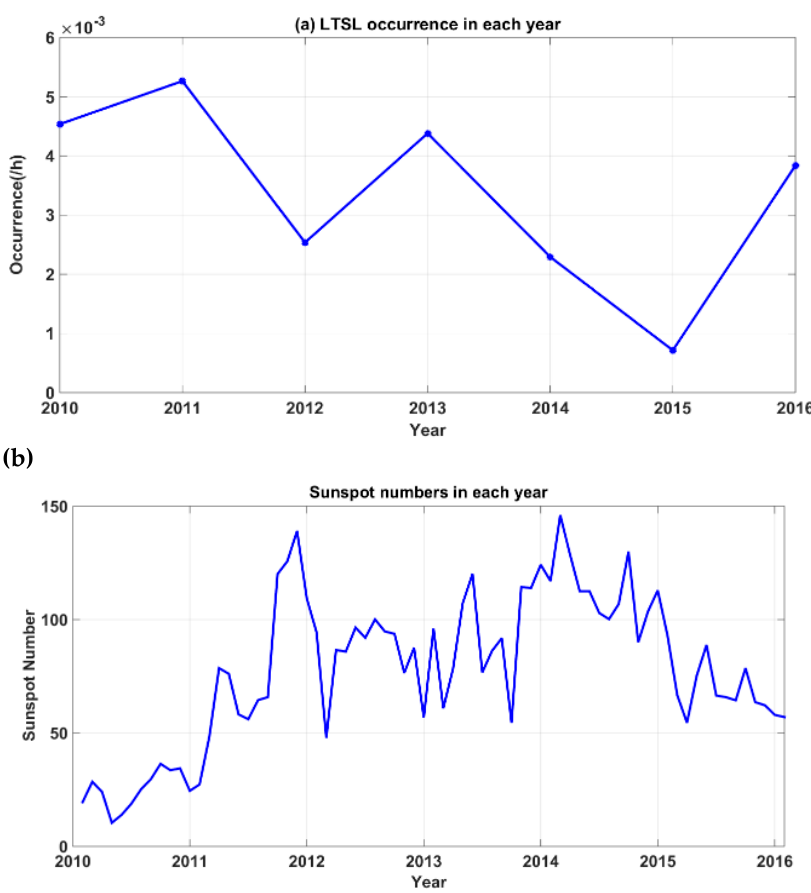
Figure 4. ( a ) The inter-annual variations of LTSL occurrence rates from 2010 to 2016. ( b ) The sunspot numbers from 2010 to 2016.